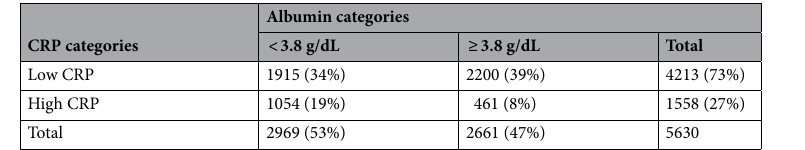
Table 1. Percentage of the patients with MIC. Proportions (%) calculated with the total (N = 5630) as the denominator. High serum CRP level was defined as greater than 3 mg/L in Japan and 10 mg/L in other DOPPS countries. MIC, malnutrition-inflammation-complex; CRP, C-reactive